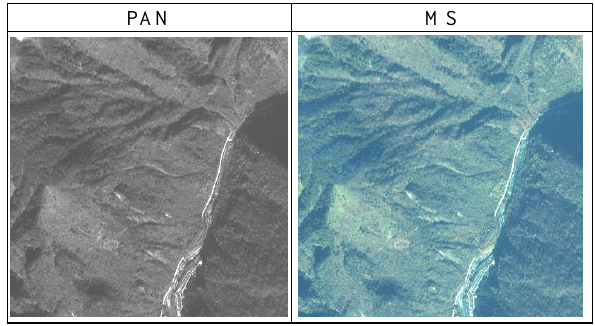
Figure 5. Data set 2, Sichuan image